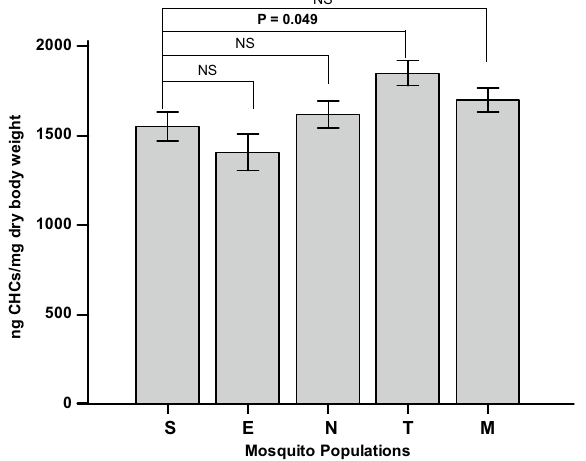
Figure 4. Mean CHC amounts from the five Culex mosquito populations. N and M mosquitoes have higher amounts of CHCs compared to S mosquitoes normalized for their size differences, but not E specimens. T mosquitoes have significantly higher CHCs compared to the S laboratory strain. Error bars: Standard Error of mean. S: Susceptible laboratory strain, E: Etam-Bafia, N: Nkolbisson, T: Tongolo, M: Mendong. NS: Not Statistically